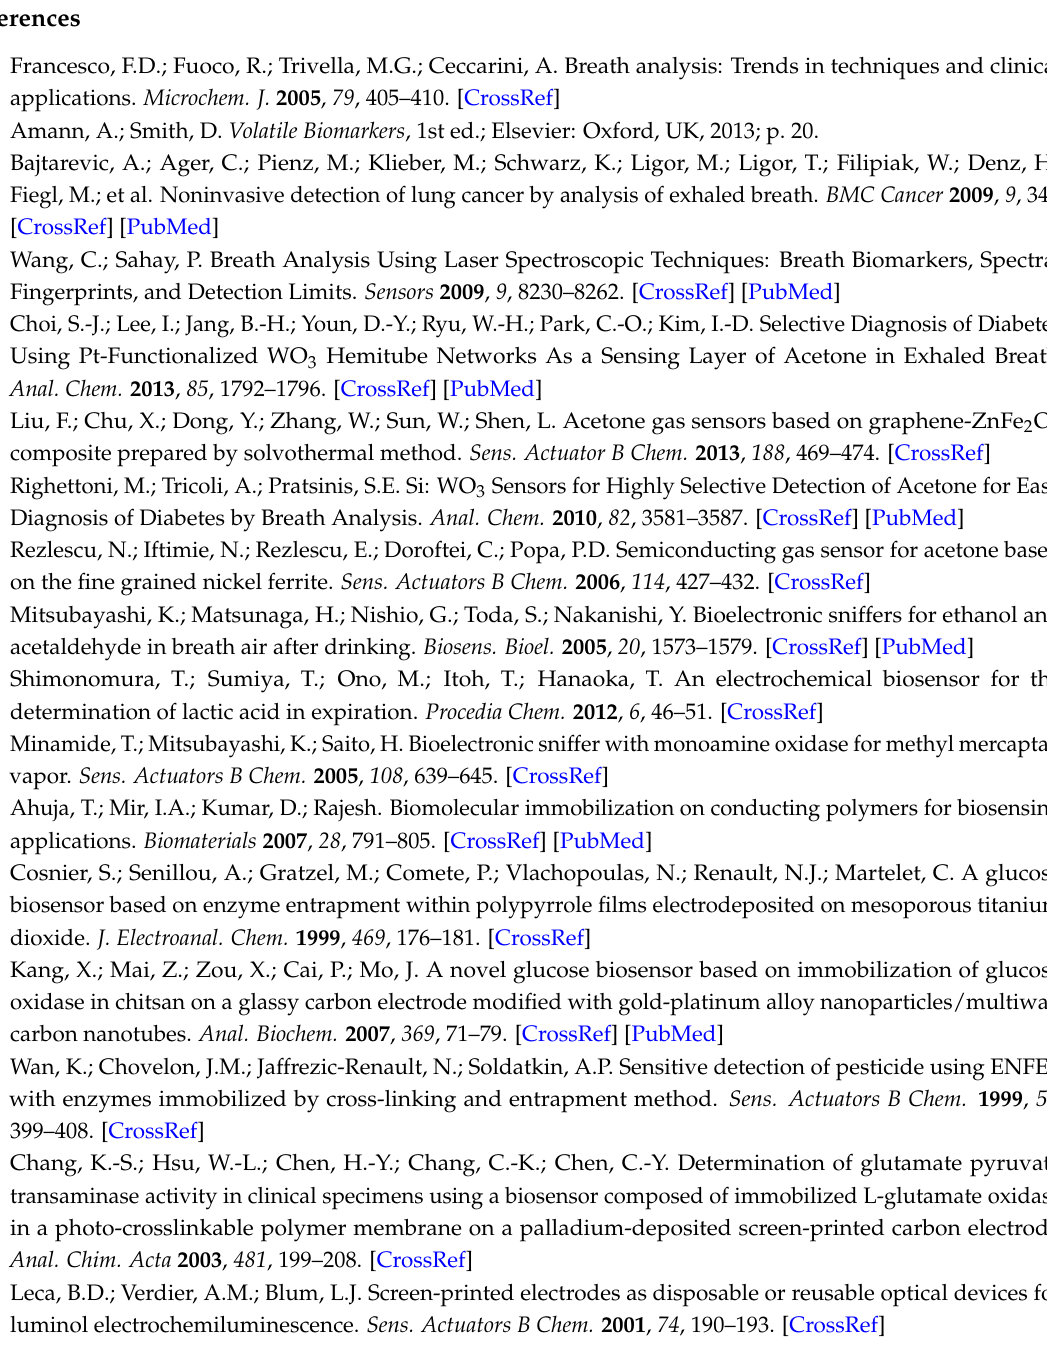
Figure S1: Sensor performance degradation during storage, Figure S2: Cyclic voltammograms, Figure S3: Enzymatic current in cyclic